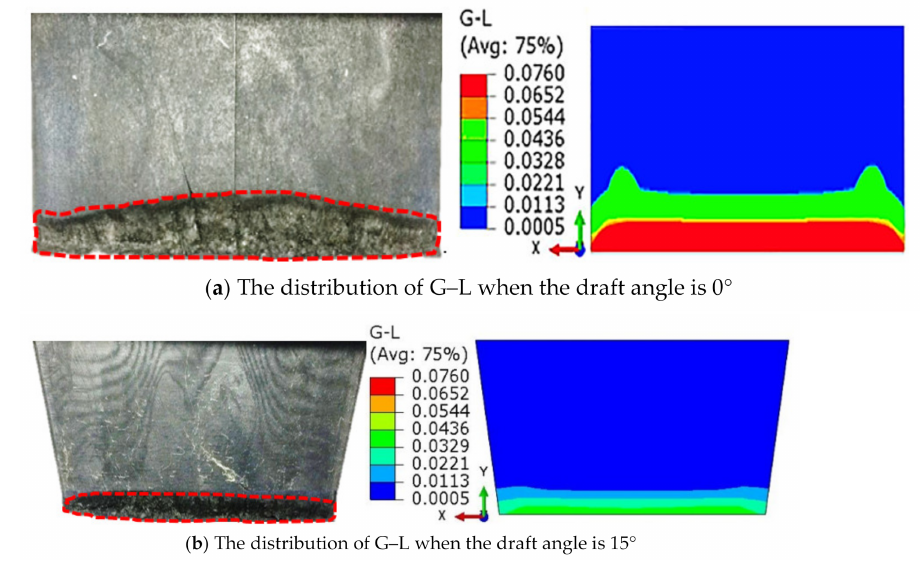
Figure 9. The simulation results of G–L and into the effects of slip angle. Further analysis of different regions on wear width was carried out, as shown in Figure 10. Wear width of the same region decreased with an increase in draft angle such as in region